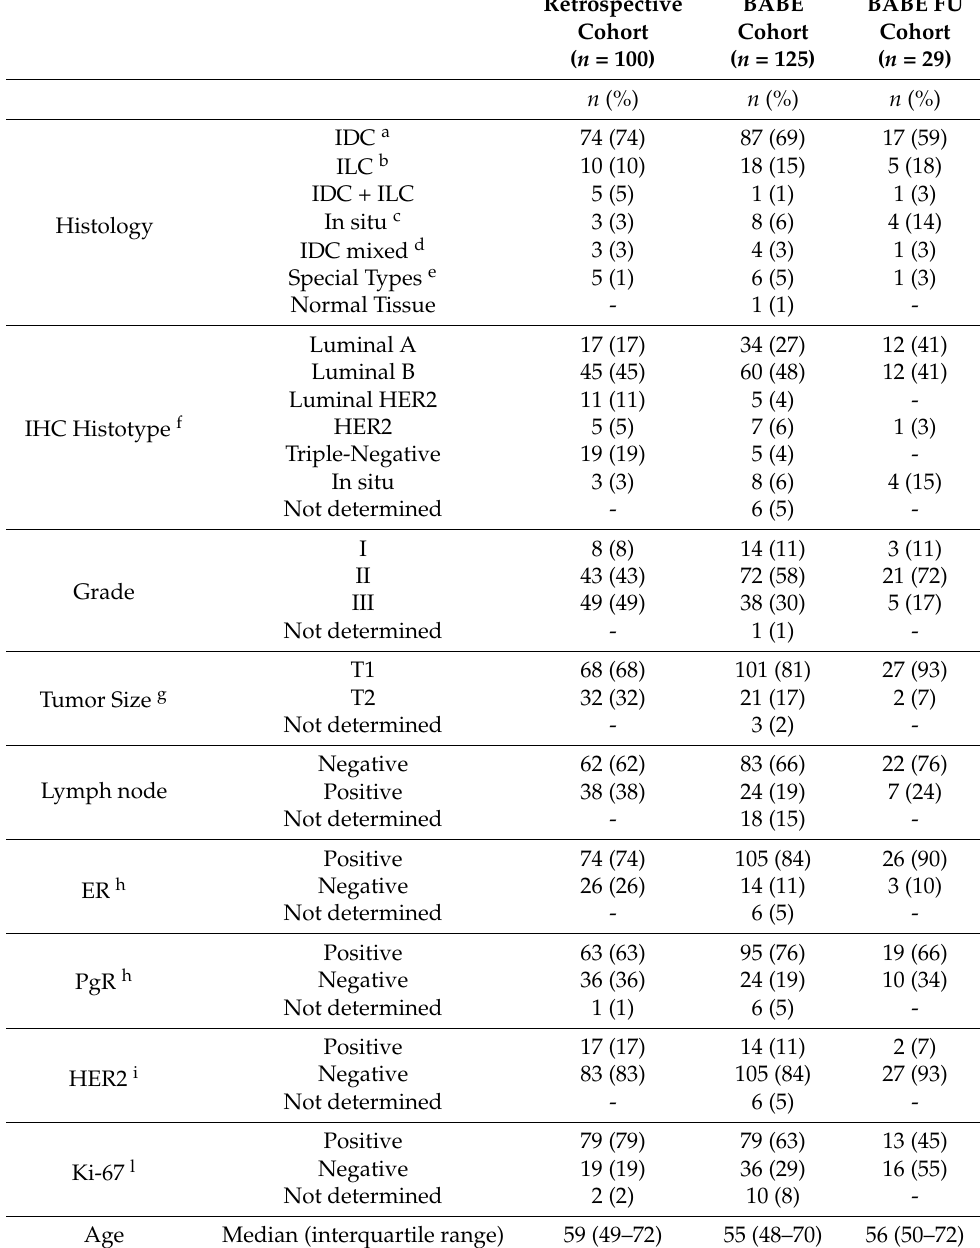
Table 1. Clinicopathological characteristics of breast cancer